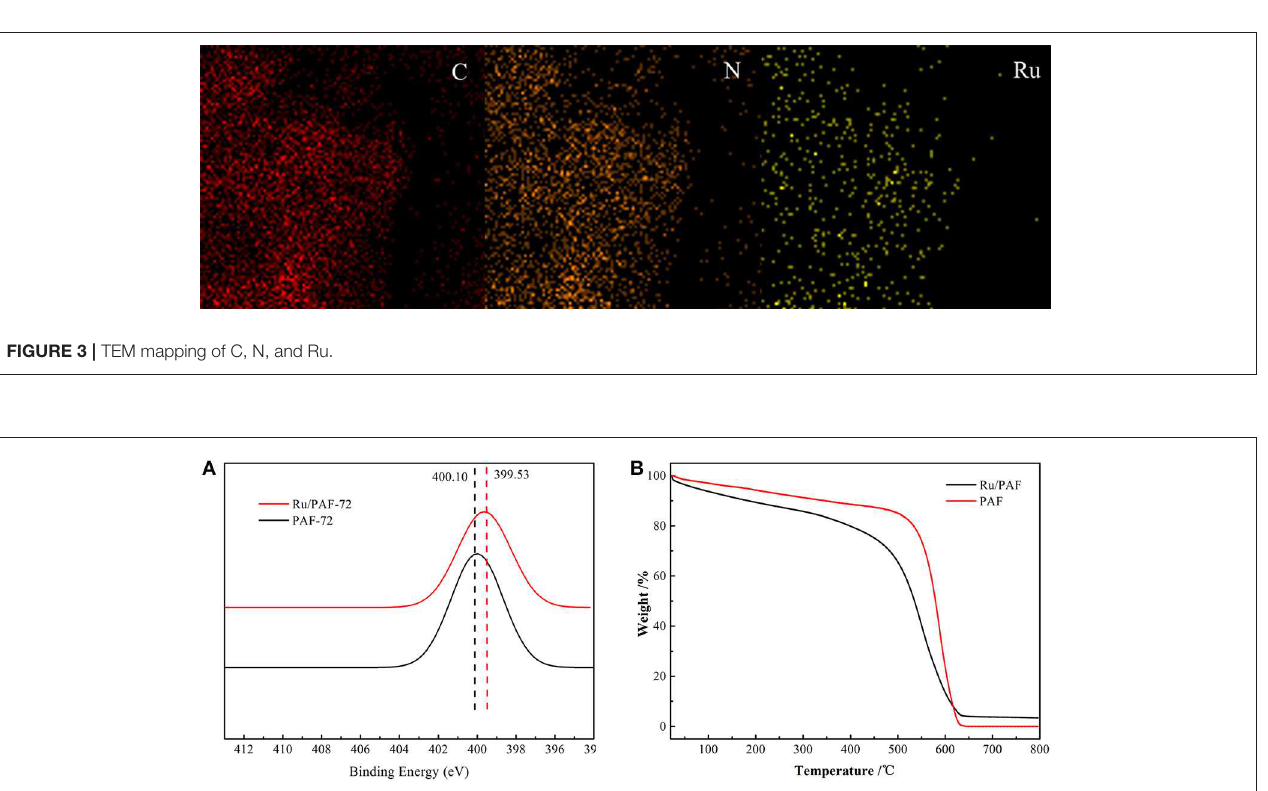
FIGURE 4 | (A) XPS spectra (N 1s) and (B) TGA plots of PAF-72 and Ru/PAF-72.